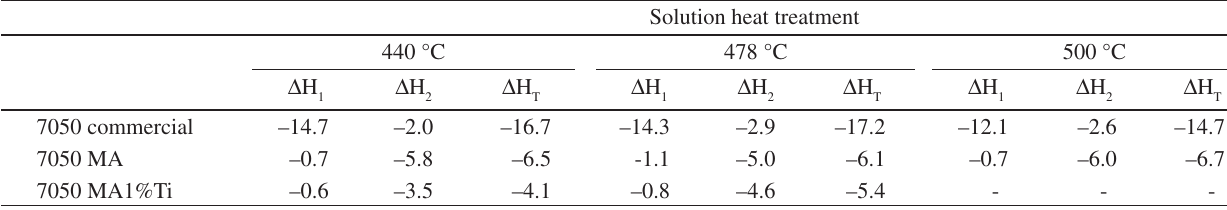
Table 2. Enthalpy releases in J.g -1 during DSC analyses of solution heat treated